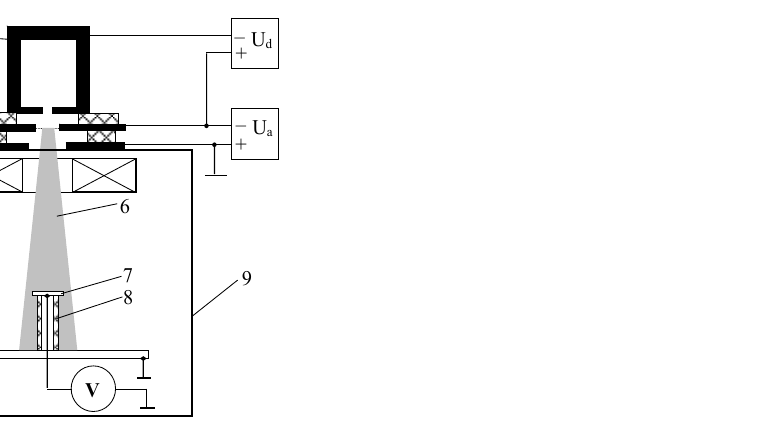
Figure 18. Experimental setup for irradiation of an insulated metal target by a cylindrical beam generated by a forevacuum plasma electron source: 1 —hollow cathode, 2 —anode, 3 —accelerating electrode, 4 —magnetic lens, 5 —collector, 6 —electron beam, 7 —metal target, 8 —insulator, 9 —vacuum chamber [128].